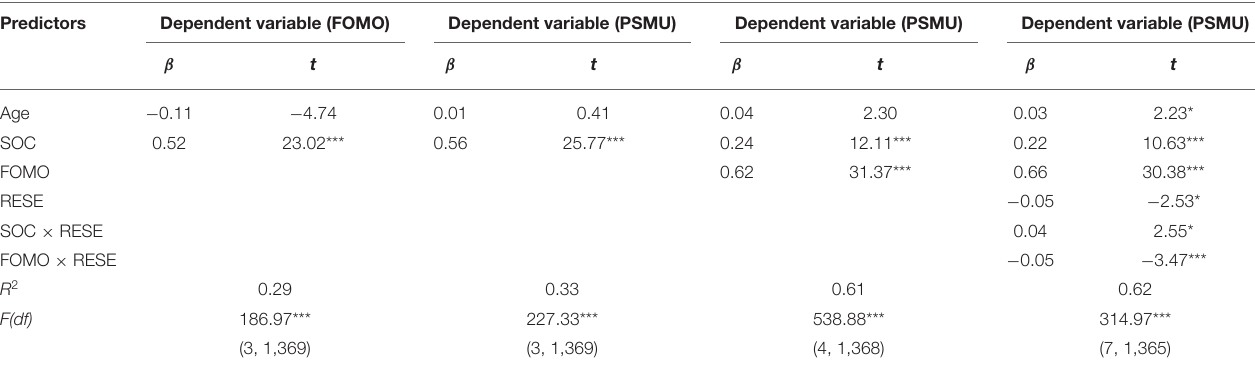
TABLE 2 | Linear regression